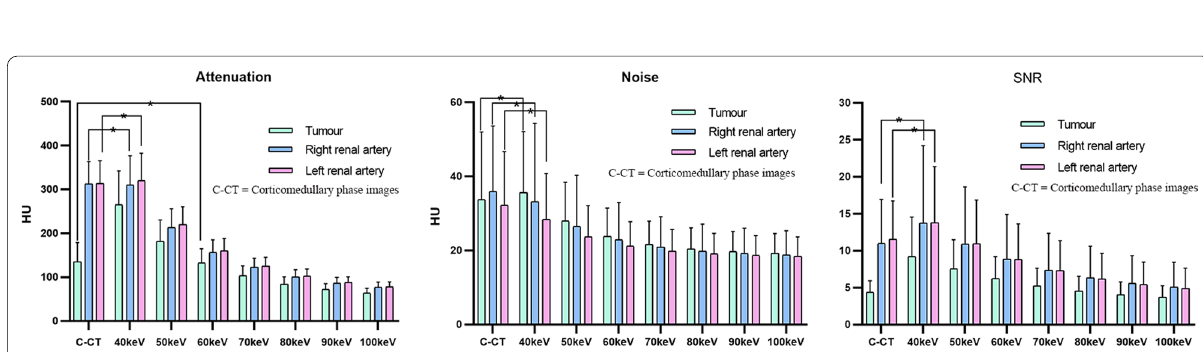
Fig. 4 Mean attenuation, image noise and SNR (signal-to-noise ratio) of kidney tumours and renal arteries on corticomedullary phase images and nephrographic phase VMIs (virtual mono-energetic images) from 40 to 100 keV. From 40 to 100 keV, the mean attenuation, image noise and SNR decreased gradually. C-CT means corticomedullary phase images. * p > 0.05